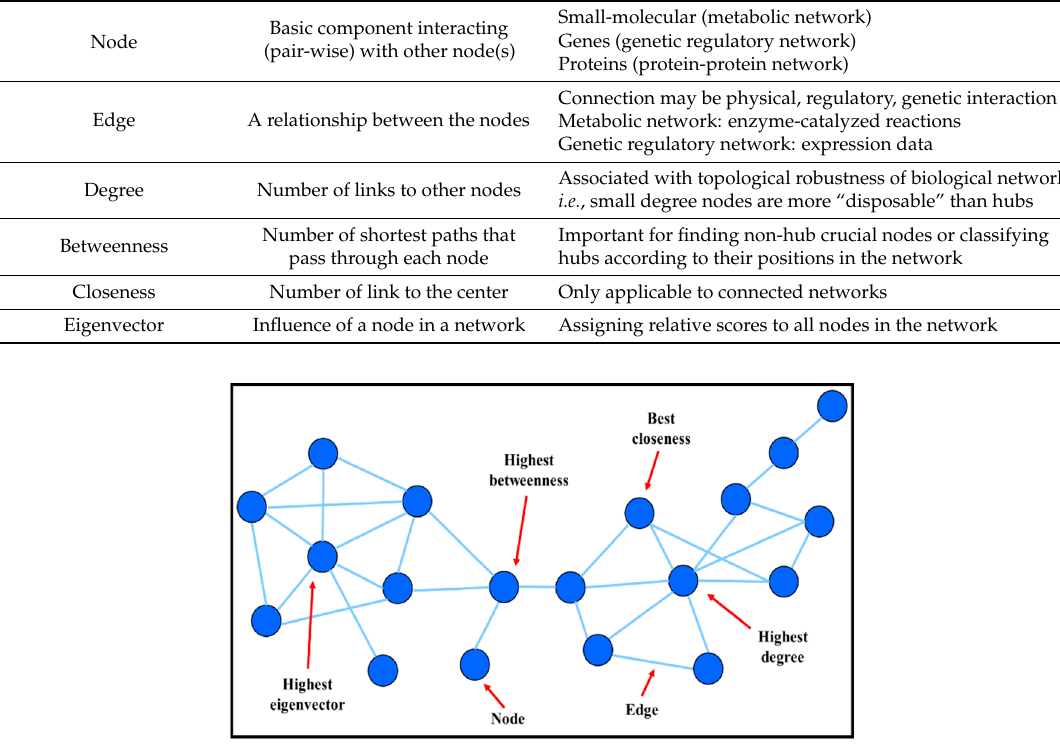
Figure 2. Topological structure of static network.